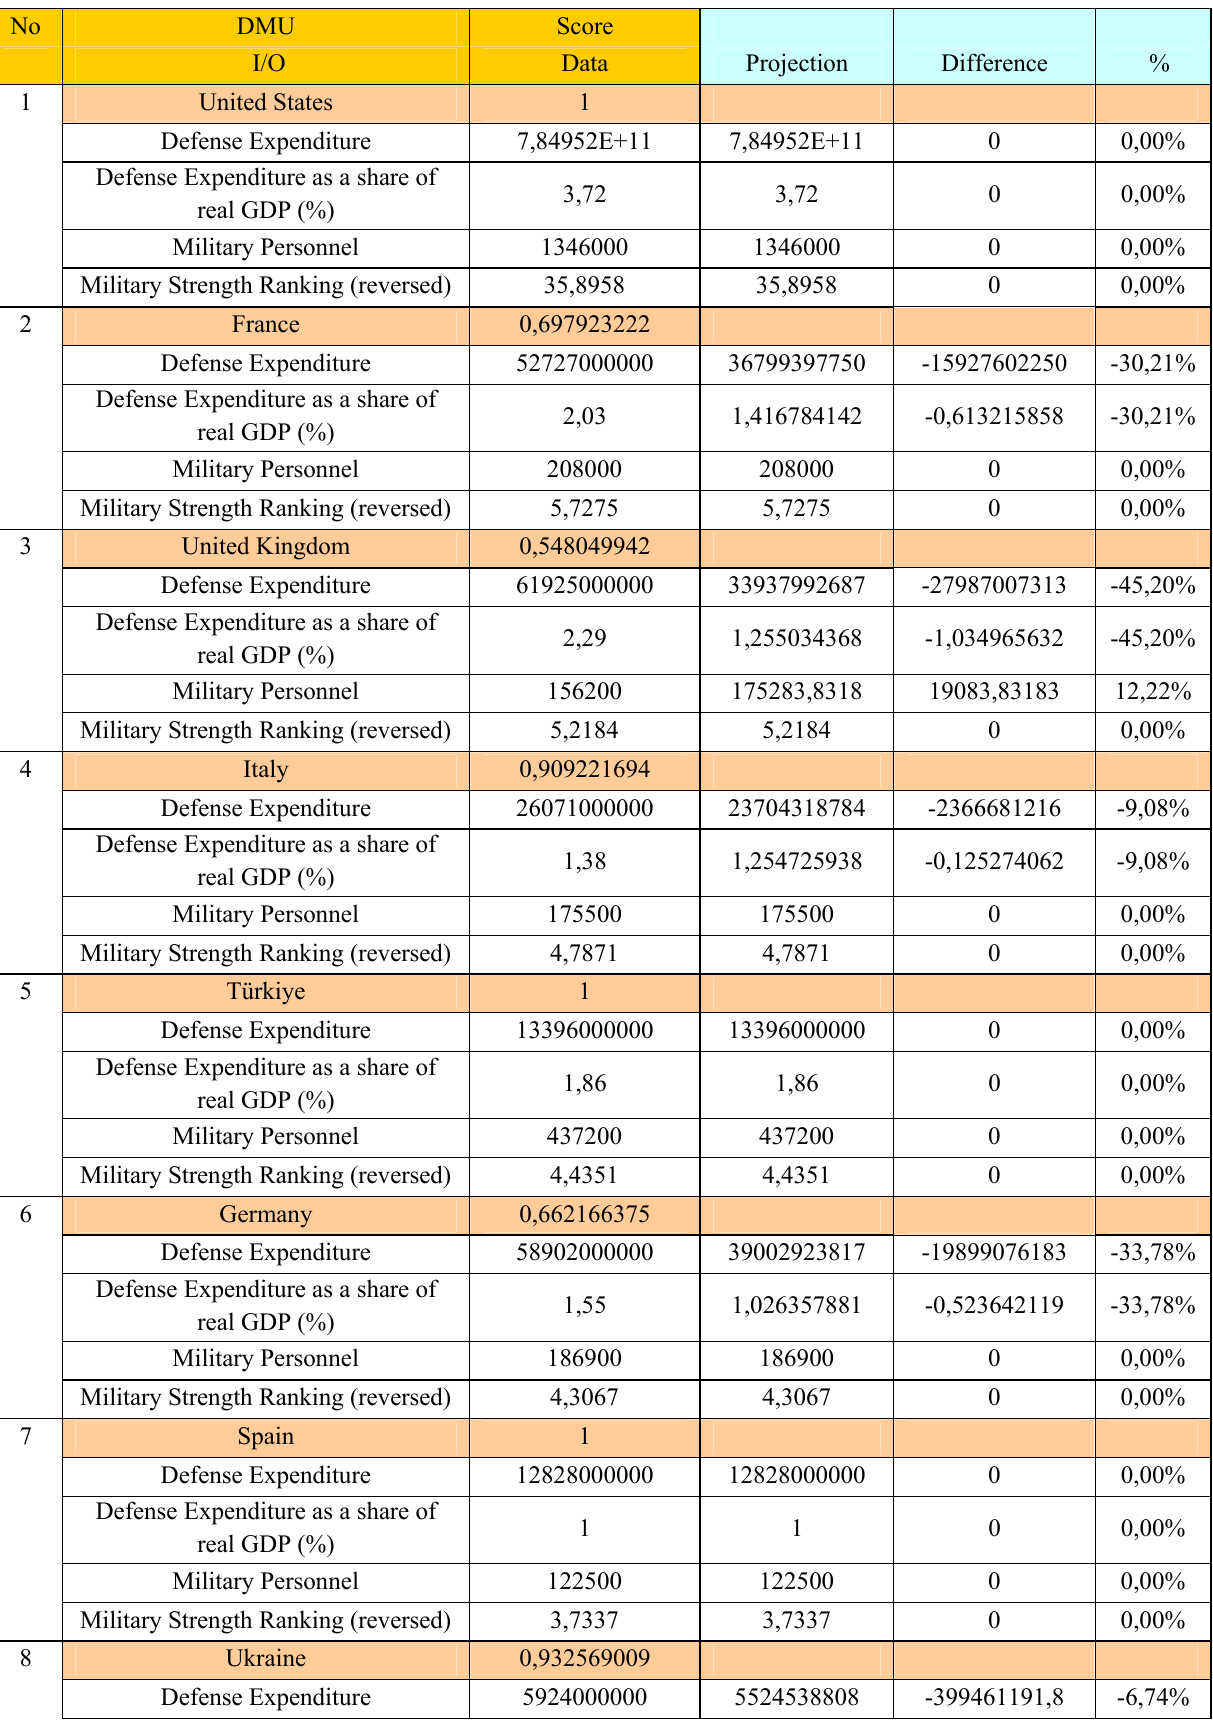
Table 4. Projections by the CCR